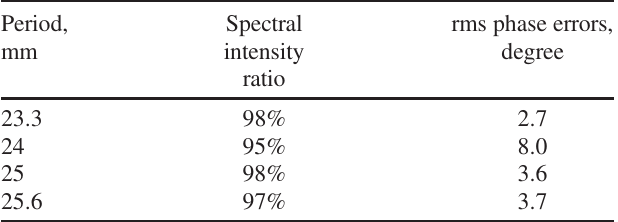
TABLE II. Spectral intensity, normalized to the ideal one, and rms phase errors for different undulator